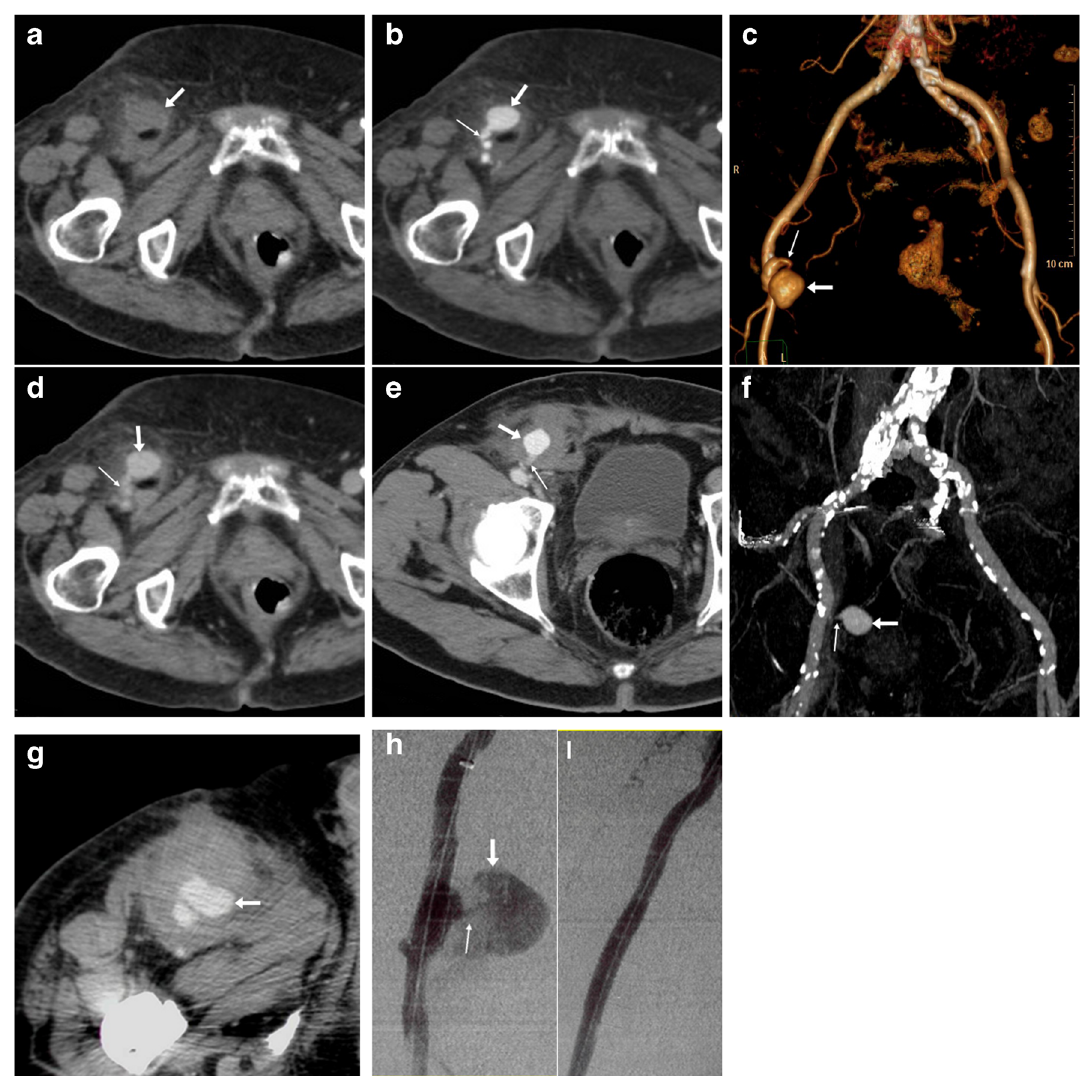
Fig. 5 Three cases of right CFA pseudoaneurysms (PA). A-D) In an 87- year-old diabetic woman suffering from blood loss following PCI precontrast (A), CT angiography (B, volume-rendering C) and venous- phase (D) images showed small-sized (2 cm) round-shaped PA (arrows) and a short feeding tract (thin arrows) communicating with the CFA. E-F) In a 75-year-old man treated with thoracic endovascular aortic repair, CT- angiography (E) and MIP reconstruction (F) showed characteristic